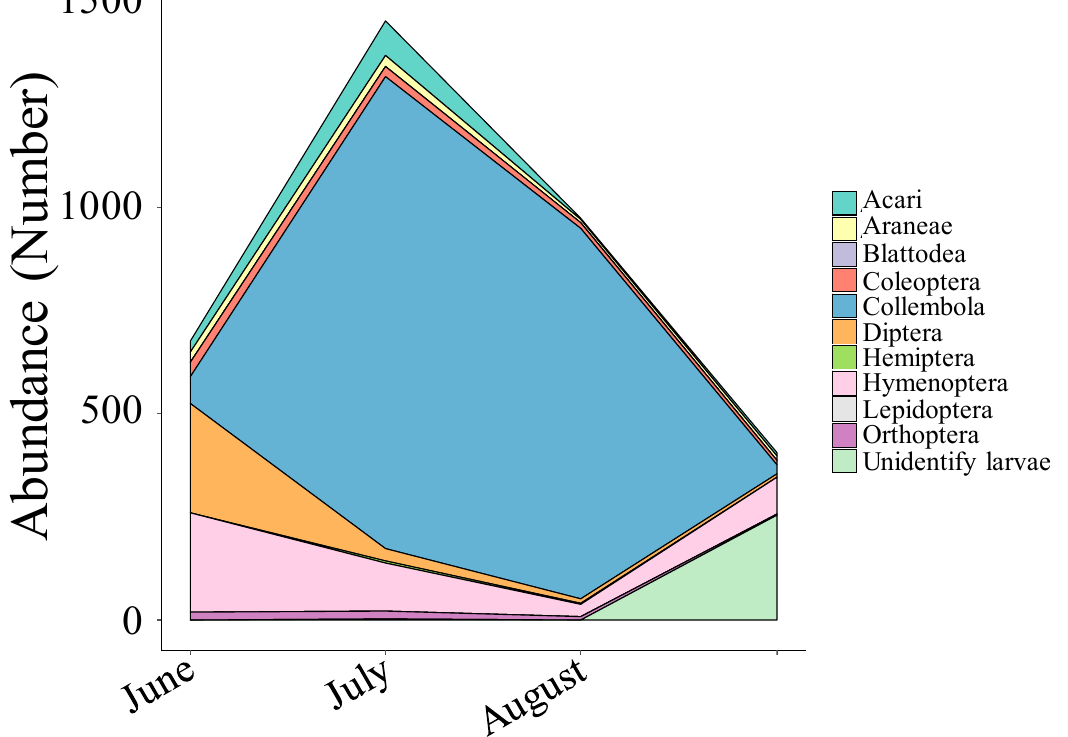
Figure 2. Abundance (number) of the identified taxa in a sisal crop from June to September 2015.